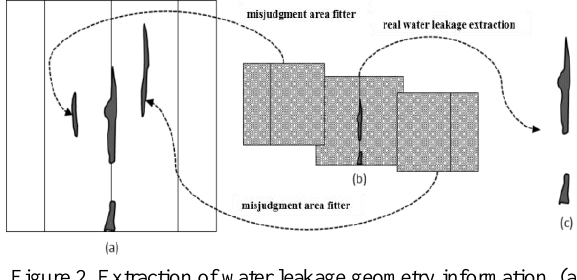
Figure 2. Extraction of water leakage geometry information.